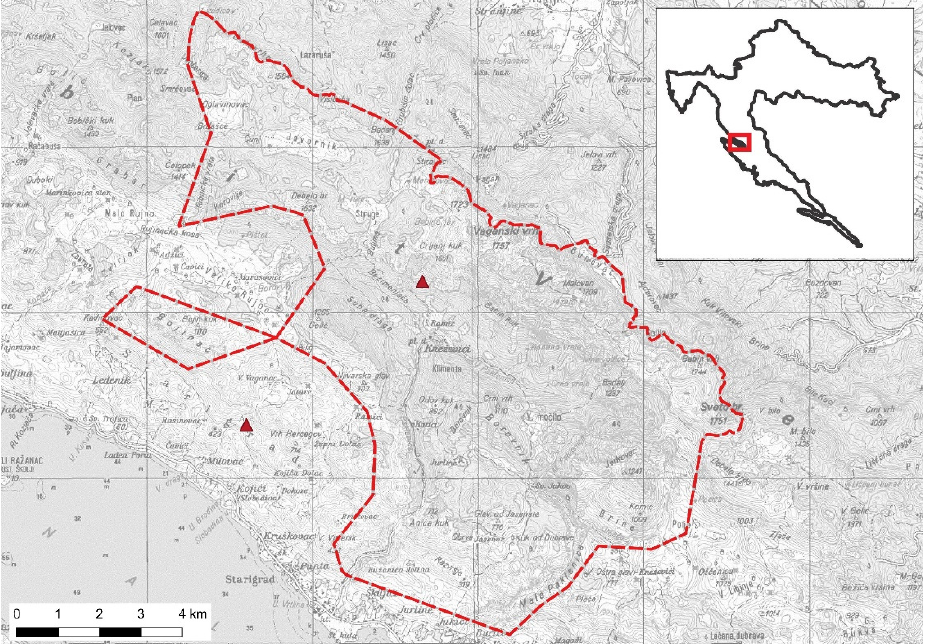
Figure 1. Paklenica National Park is located close to the Adriatic coast northeast of Starigrad, Croatia. Red dashed line shows the border of the National Park; red triangles show denning sites of the two female bears. Scale: 1:75,000. Small map (top right) shows the location of the National Park (red) in Croatia.